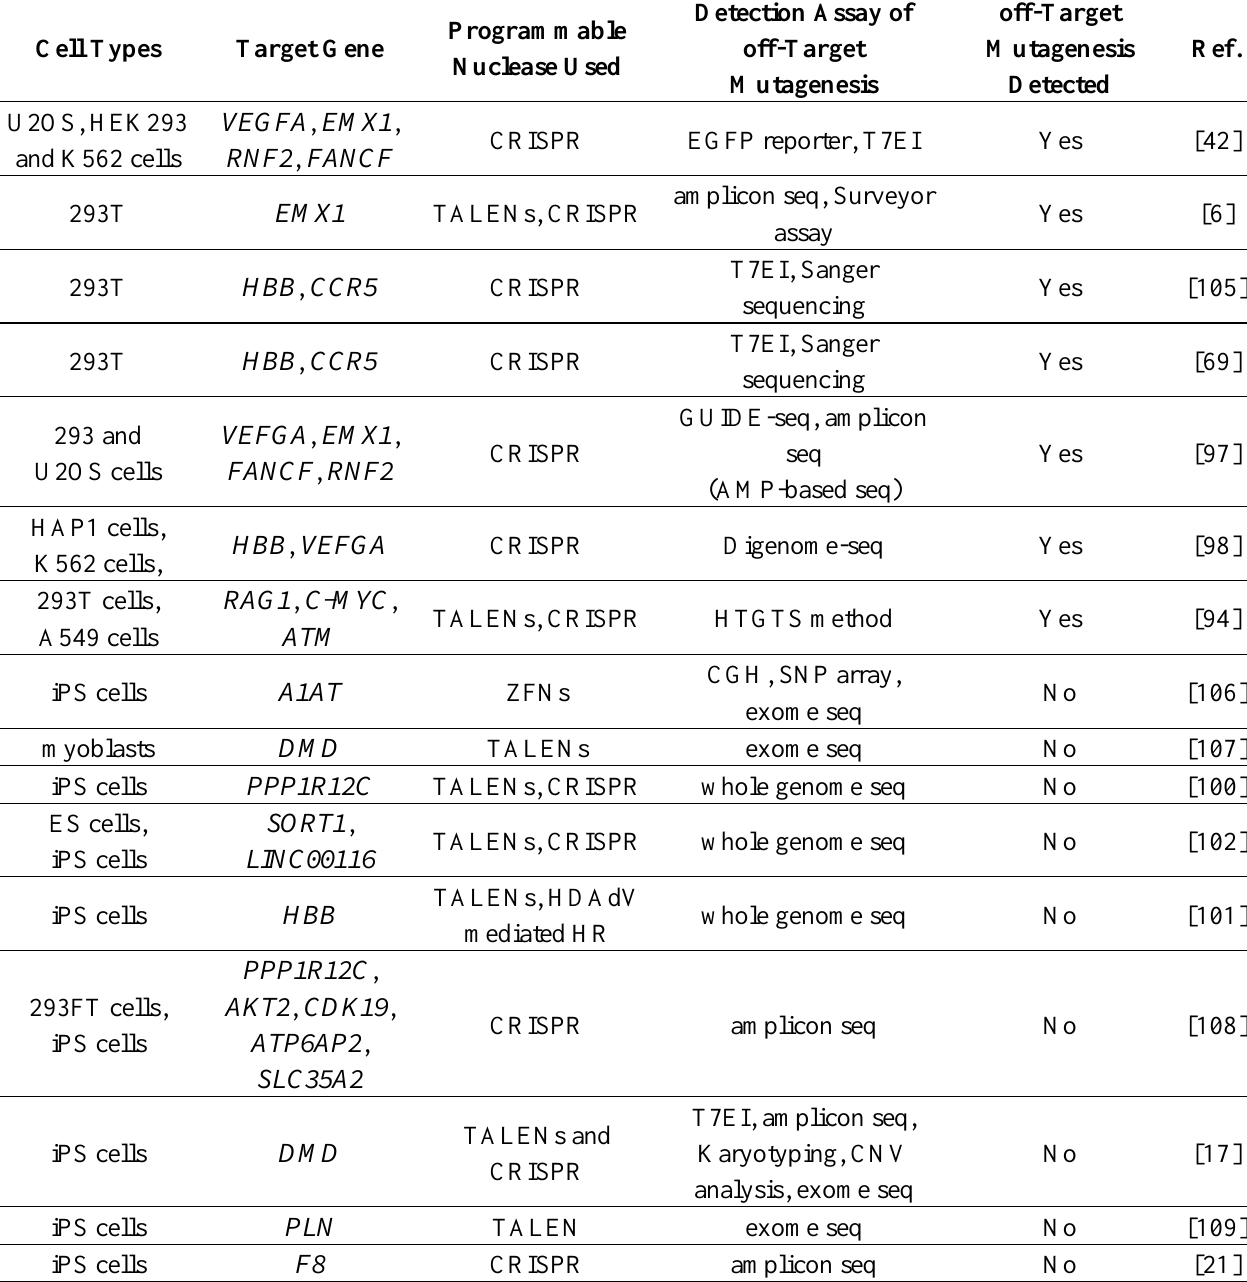
Table 2. Summary of studies detecting off-target mutagenesis using different cell